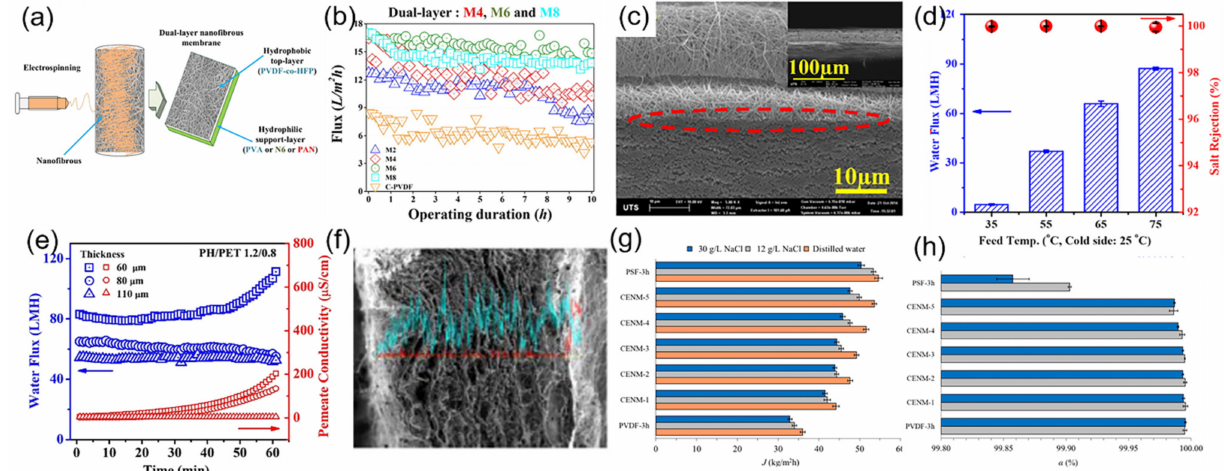
Figure 8. ( a ) Schematic diagram of the fabrication process of dual-layer ENMs; ( b ) permeance performance of the prepared ENMs; Reprinted with permission from Ref. [126]. 2017, Elsevier. ( c ) cross section SEM images of the optimized dual-layer ENMs; ( d , e ) permeating performance and stability test in different conditions of thermal and strain; Reprinted with permission from Ref.